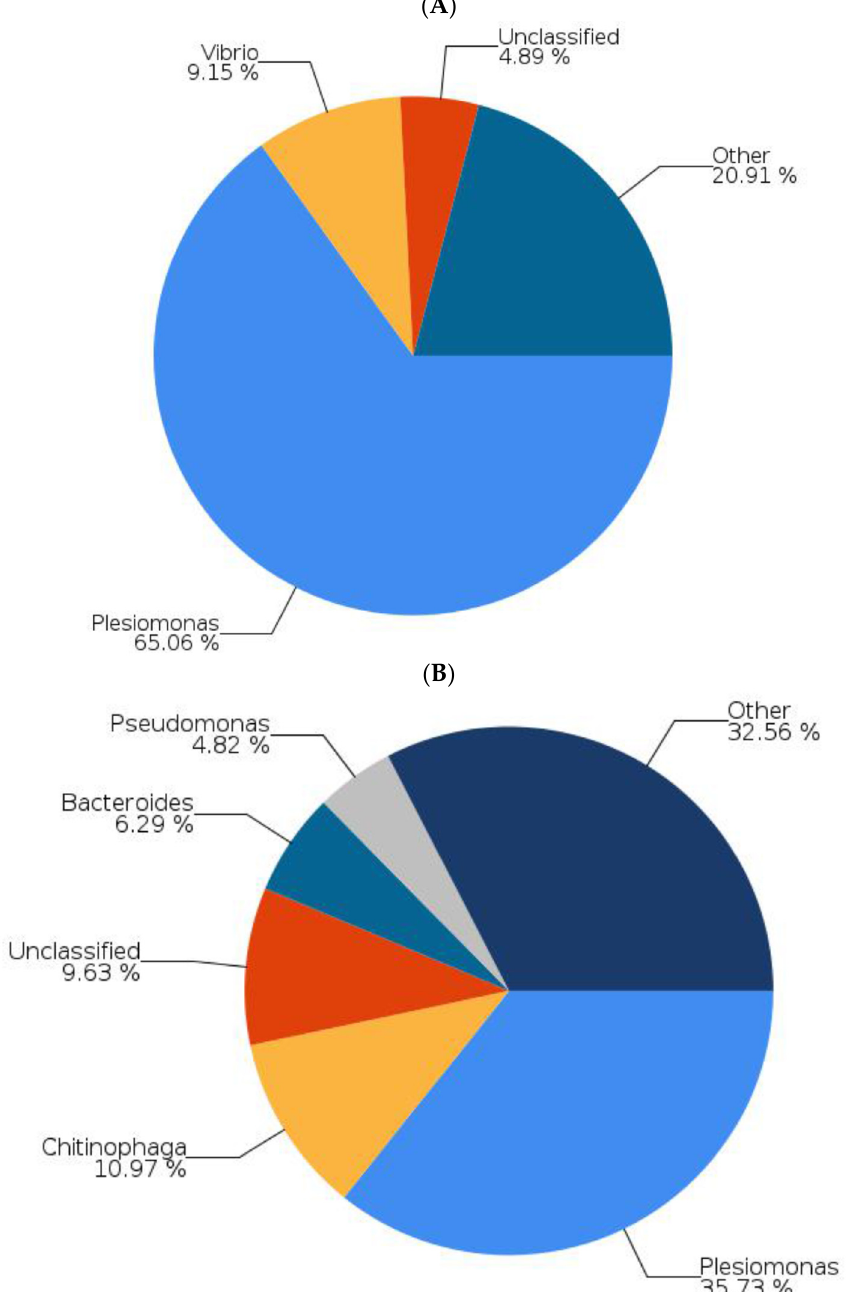
Figure 4. Bacterial structure of different species in the gut of zebrafish fed a normal diet ( A ) or those soybean tempeh fermented with Rhizopus oryzae MH-001 ( B ) assessed by next-generation sequencing. Data under 1% not shown.